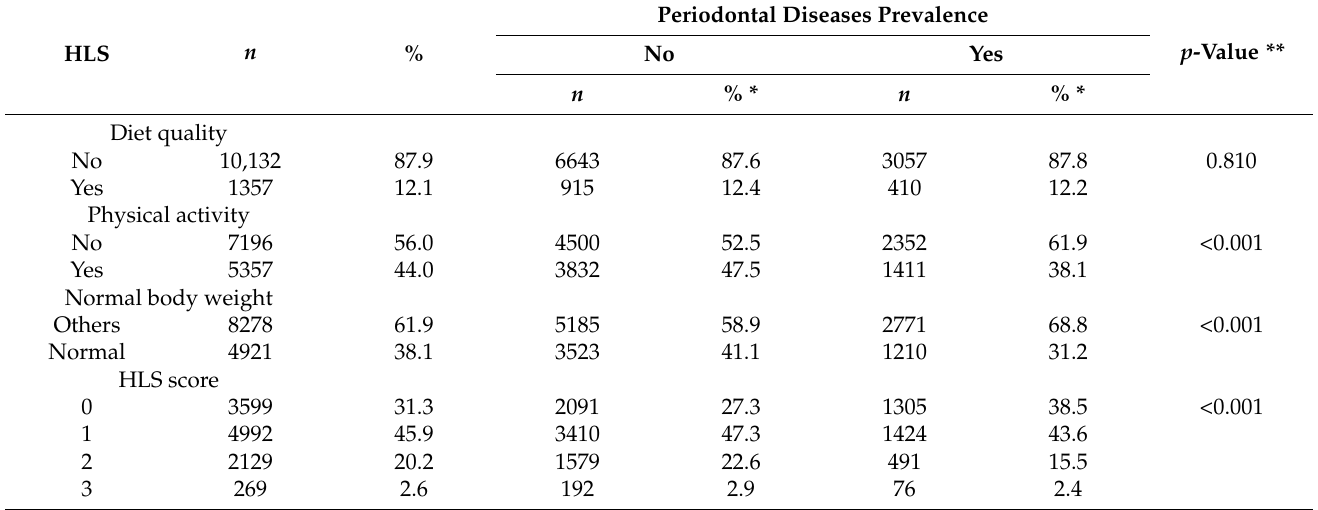
Table 2. Prevalence of Periodontal Diseases According to HLS